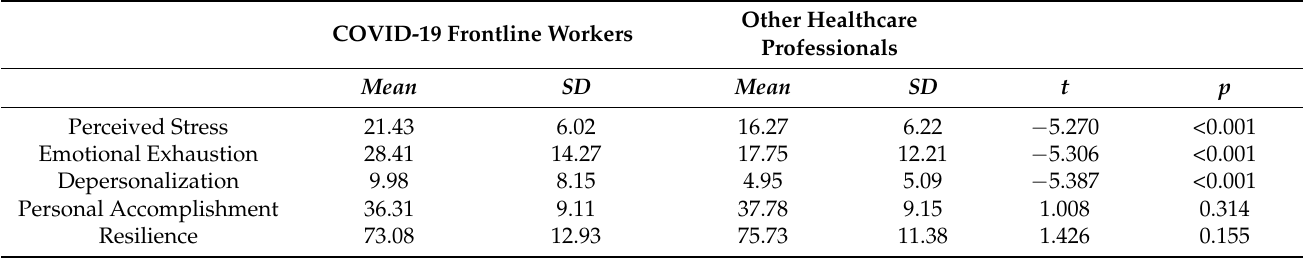
Table 2. Differences in stress, burnout, and resilience between COVID-19 frontline workers ( N = 51) and healthcare professionals working in other units ( N =